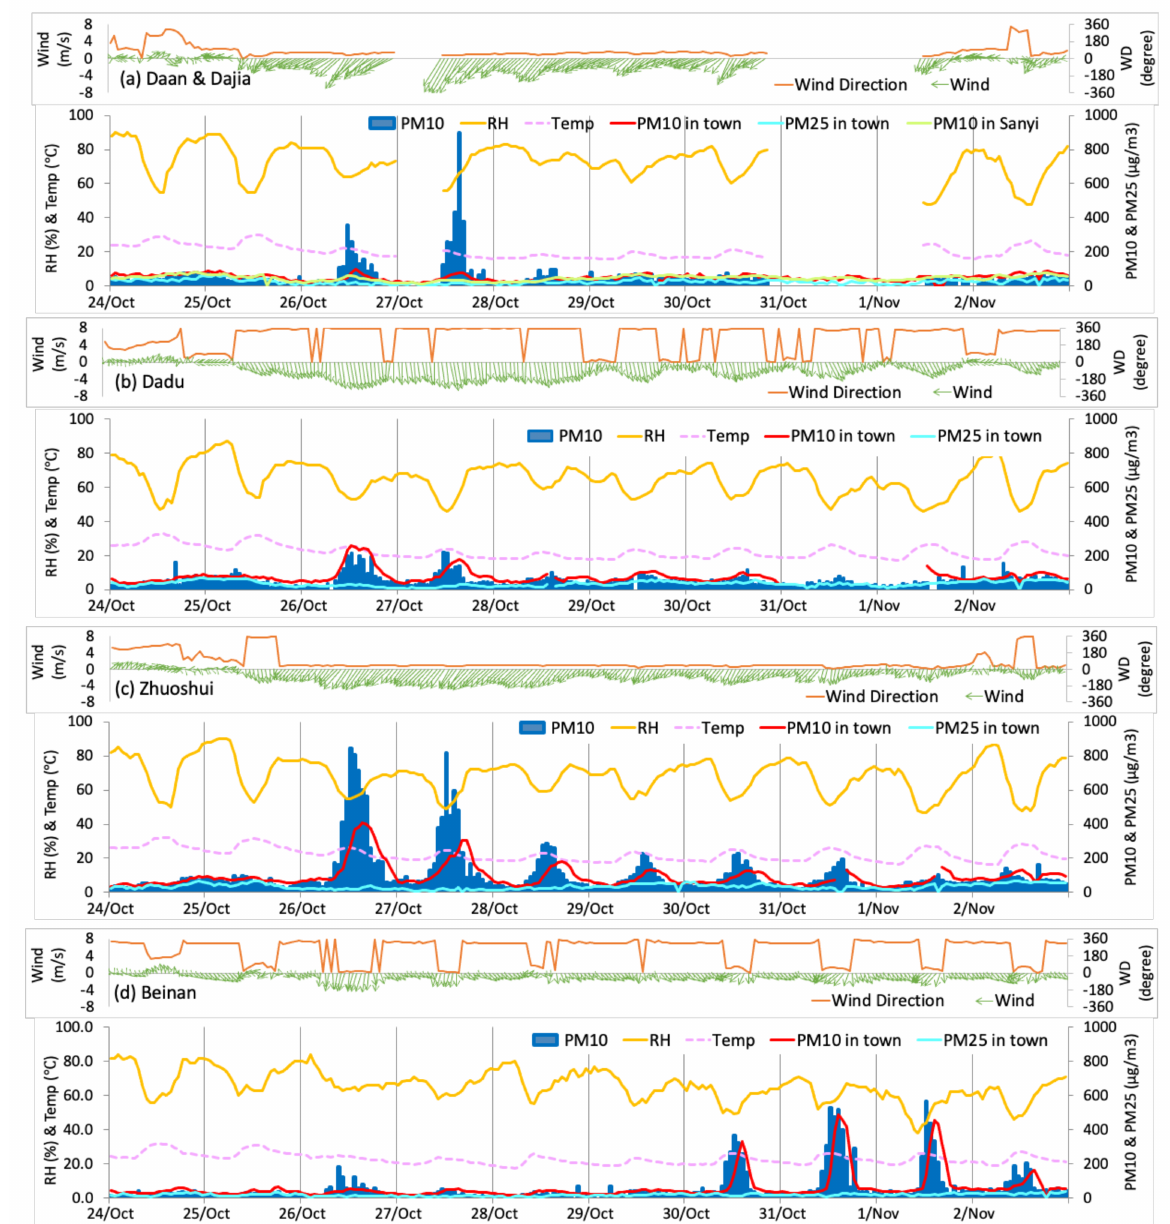
Figure 5. The typhoon type meteorological conditions and aerosol concentration, including wind speeds and directions (wind and WD), relative humidity (RH), temperature (Temp), and PM 10 concentration observed at ( a ) Daan and Dajia, ( b ) Dadu, ( c ) Zhuoshui, and ( d ) Beinan riverbed monitoring stations from 24 October to 2 November 2010. PM 10 and PM 2.5 observed in the town nearby each riverbed stations and PM 10 in the Sanyi background station are also